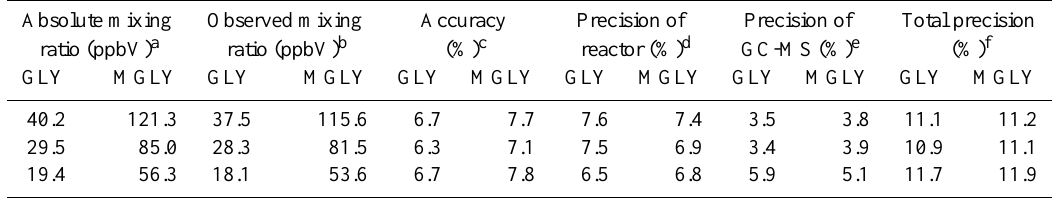
Table 3. Accuracy and precision of the microfluidic derivatisation technique Absolute mixing